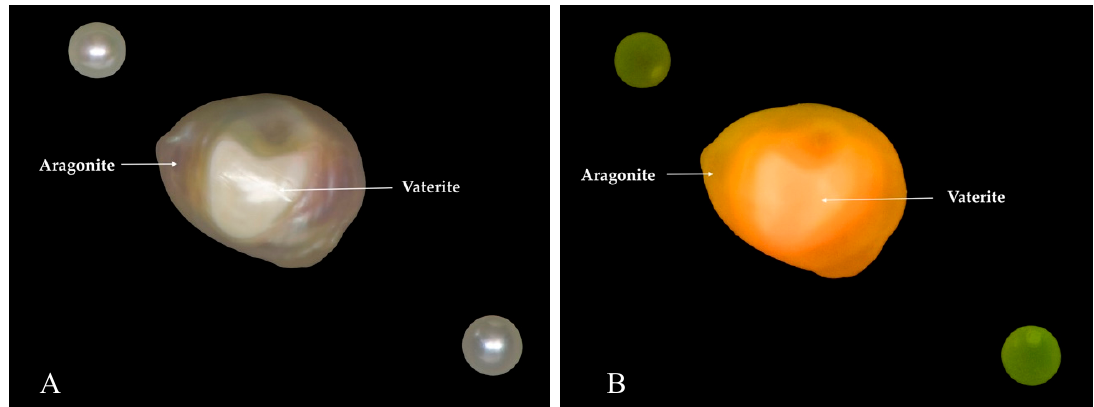
A B Figure 10. Natural freshwater pearl under daylight ( A ) and under X-rays ( B ); orange coloured part is made of vaterite (verified by Raman; see Figure 11). The two freshwater samples upper left (diameter: 2.85 mm) and bottom right (diameter: 2.95 mm) were used as references.